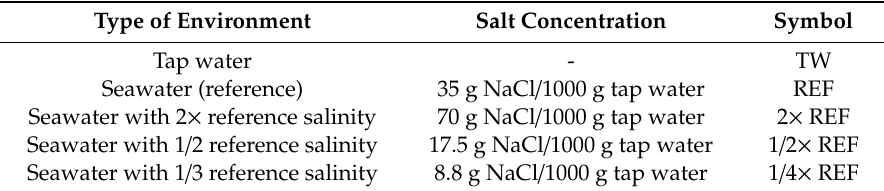
Table 4. Tested environments with di ff erent salt